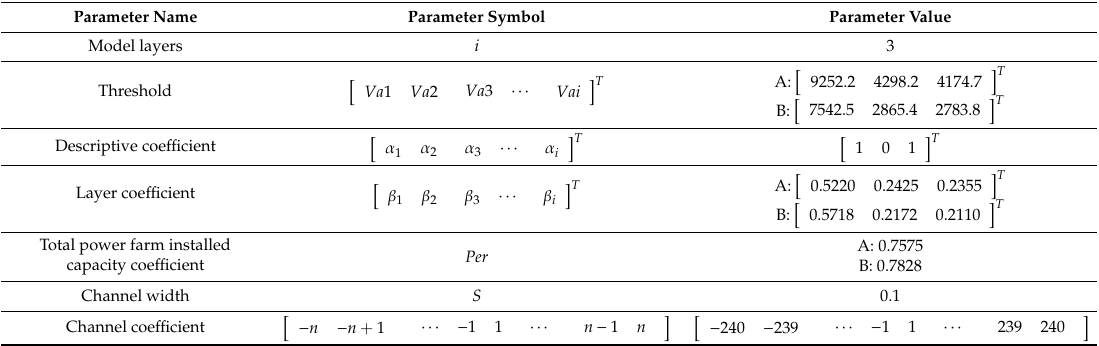
Table 3. Parameters of channel self-selection multi-layer coefficient correction model (CSMCC) in No. 1 and No. 2 power systems.